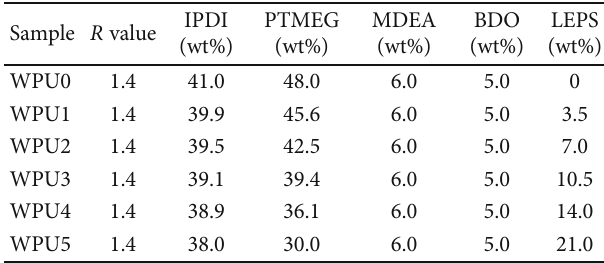
Figure 1: Molecular structure of LEPS. Table 1: Compositions of LEPS modi fi ed WPU